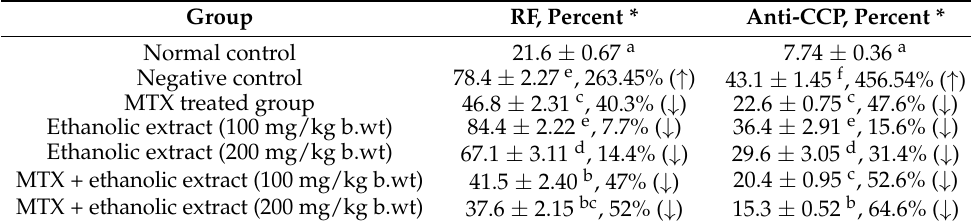
Table 1. Effect of different treatments on the levels of diagnostic markers of rheumatoid arthritis (RF and